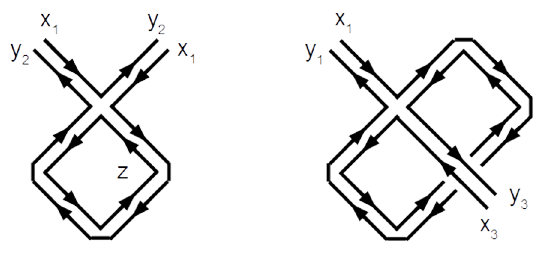
Figure 4 . The two diagrams for the computation of the one-loop two-point